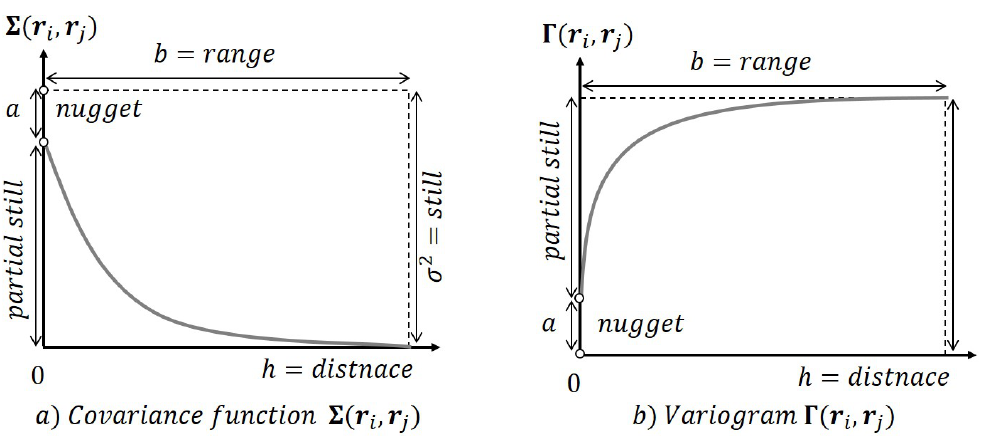
Figure 2. Covariance and variogram